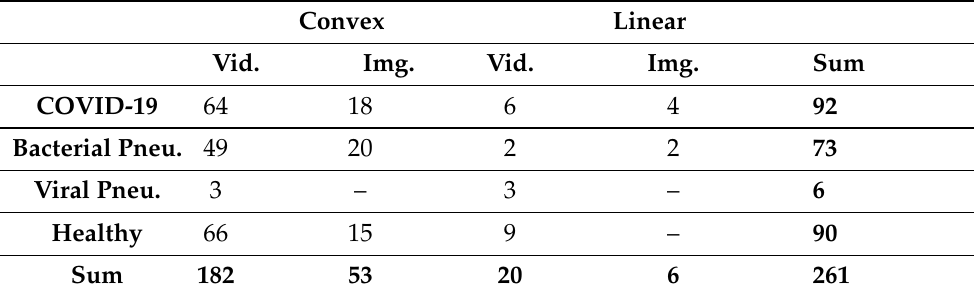
Table 1. Dataset size. Number of videos and images in our dataset, per class and probe. Convex Linear Vid. Img.